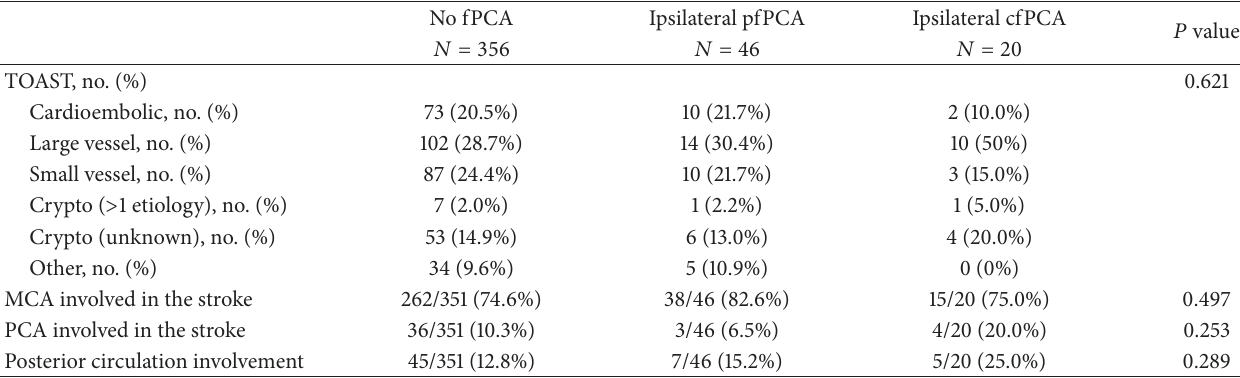
Table 2: TOAST classification and vessel involvement in patients without fetal PCA (no fPCA), partial fetal PCA with ipsilateral stroke (ipsilateral pfPCA), and complete fetal PCA with ipsilateral stroke (ipsilateral cfPCA).